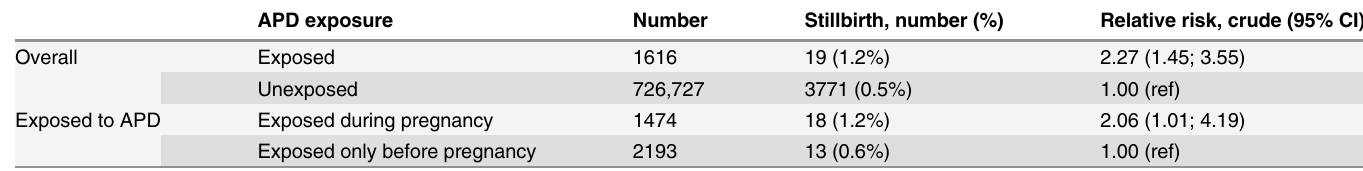
Table 6. Relative risks of stillbirth following APD exposure in pregnancy (numbers refer to pregnancy outcomes